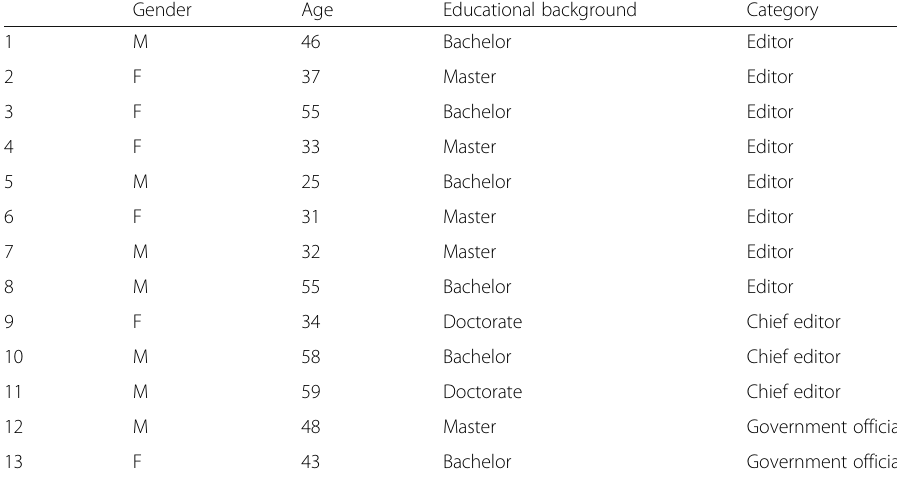
Table 1 Interviewees with their basic background information Gender Age Educational